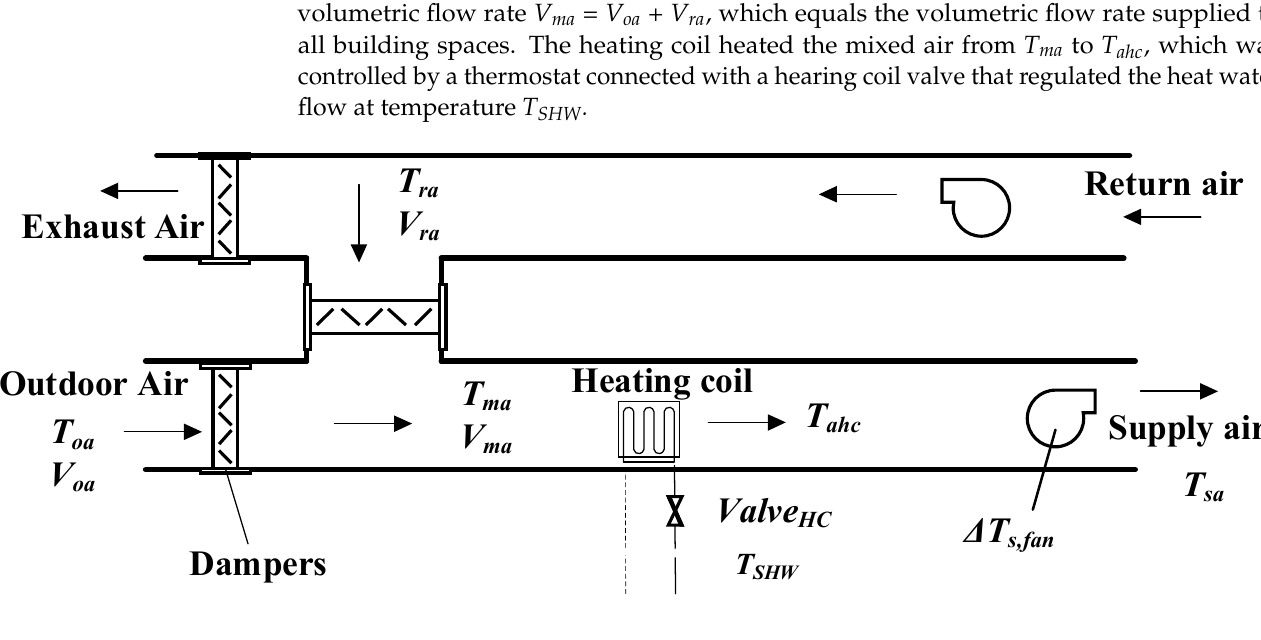
Figure 2. Schematic of air handling unit Figure 2 . Schematic of air handling unit (AHU). Table 2 . List of AHU variables.